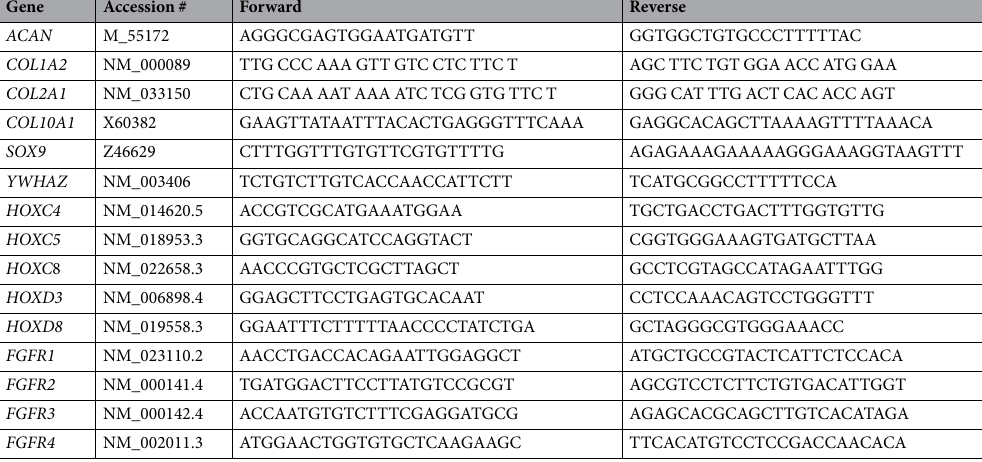
Table 1. RT-qPCR Primer